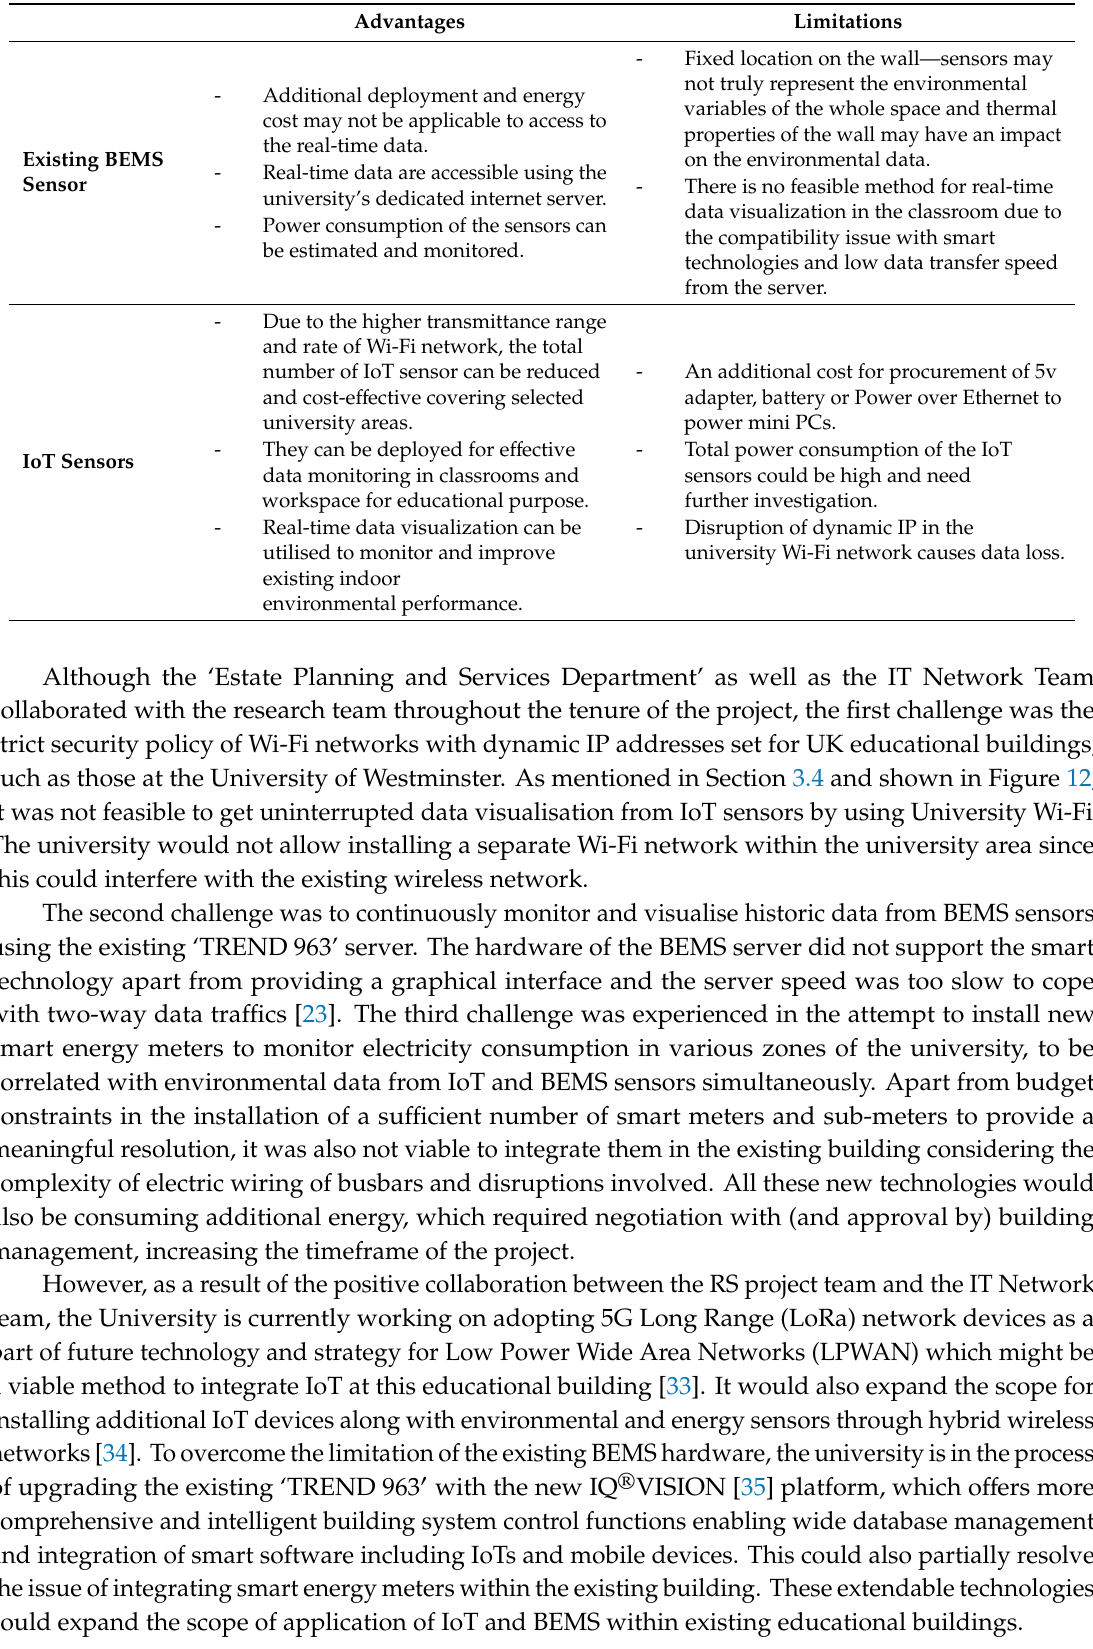
Table 3. Advantages and limitation of utilising BEMS and IoT sensors in the case study